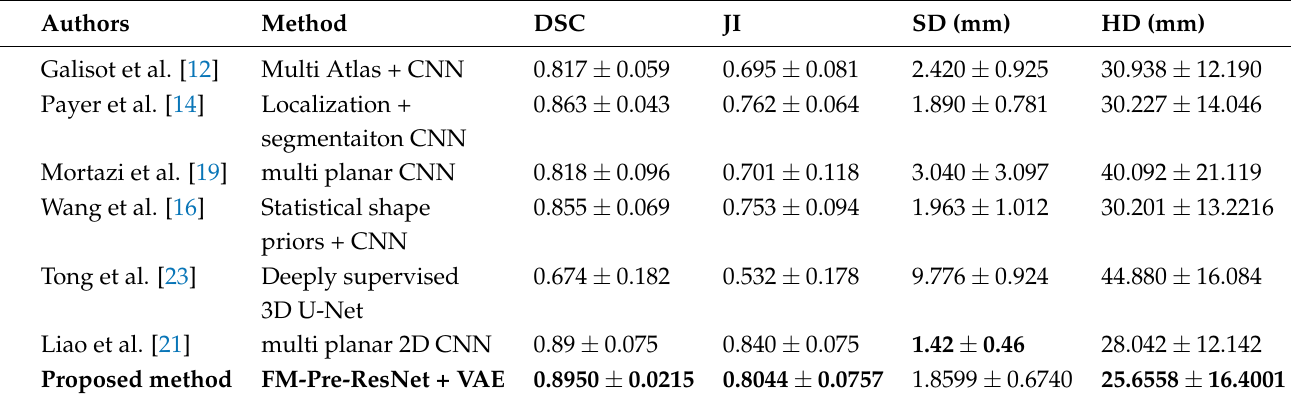
Table 7. Comparison of an average DSC, JI, SD, and HD of the state-of-the-art whole heart segmentation methods on MRI